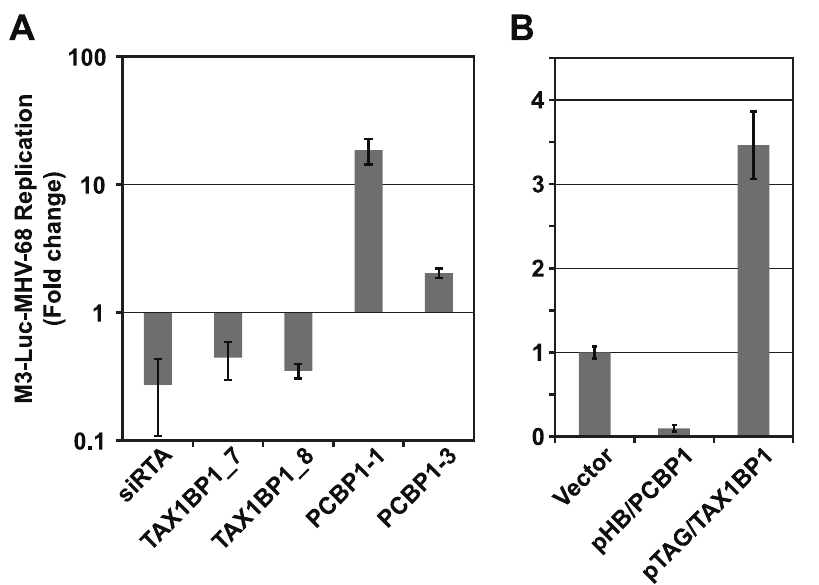
Figure 6. PCBP1 and TAX1BP1 have opposing effects on MHV-68 replication. (A) Effect of siRNAs against PCBP1 and TAX1BP1 on MHV-68 replication. Two distinct siRNAs for each gene were tested for their effect on the replication of M3-Luc-MHV-68 as outlined in Fig. 5. Luciferase values were normalized to the level of replication in cells transfected with the negative control siRNA (siGL3). siRTA is a positive control siRNA against the viral RTA. (B) Effect of over-expressing PCBP1 and TAX1BP1 on MHV-68 replication. HEK293T cells were transfected with parental vector pHB (vector), pHB/PCBP1, or pHB/TAX1BP1 and infected with M3-Luc-MHV-68 as in Fig. 5.